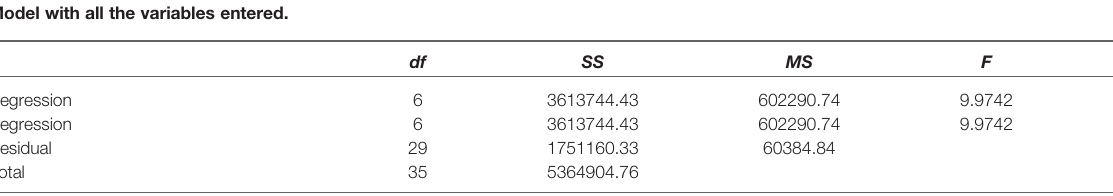
TABLE 2 | Stepwise multivariate regression analysis. Model with all the variables entered.